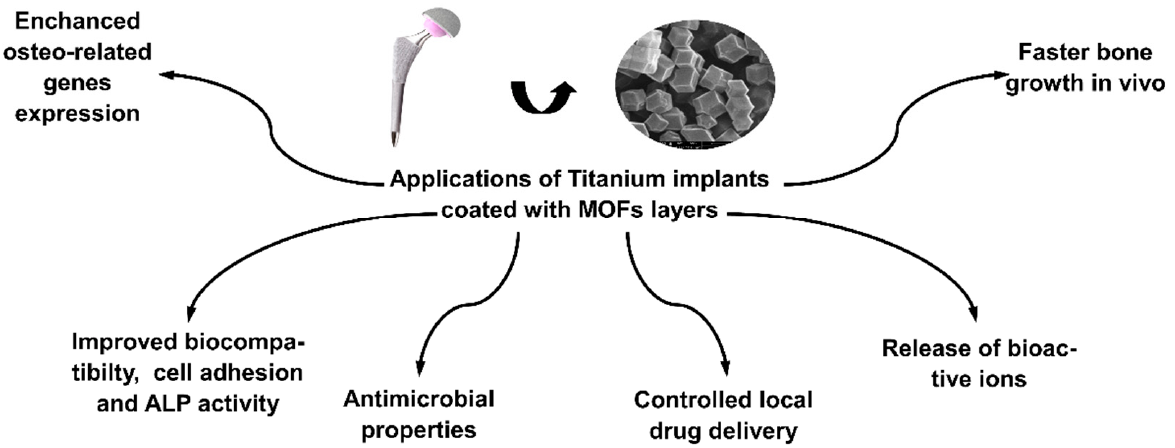
Figure 4. Examples of the applications of MOFs as a coating on titanium alloy.